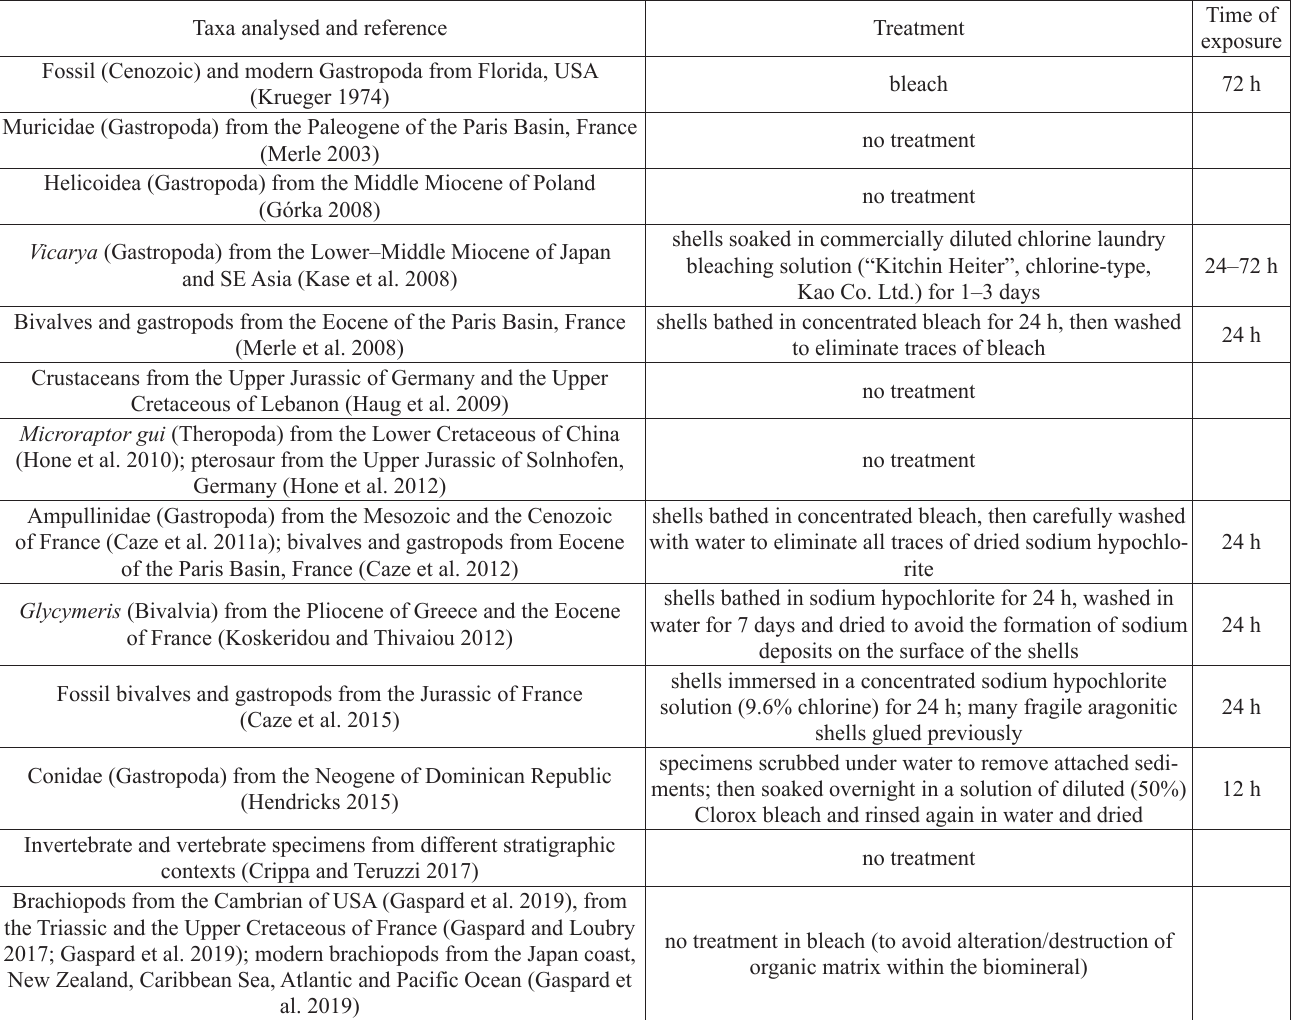
Table 1. Different treatments used for preparing fossil and modern specimens to UV